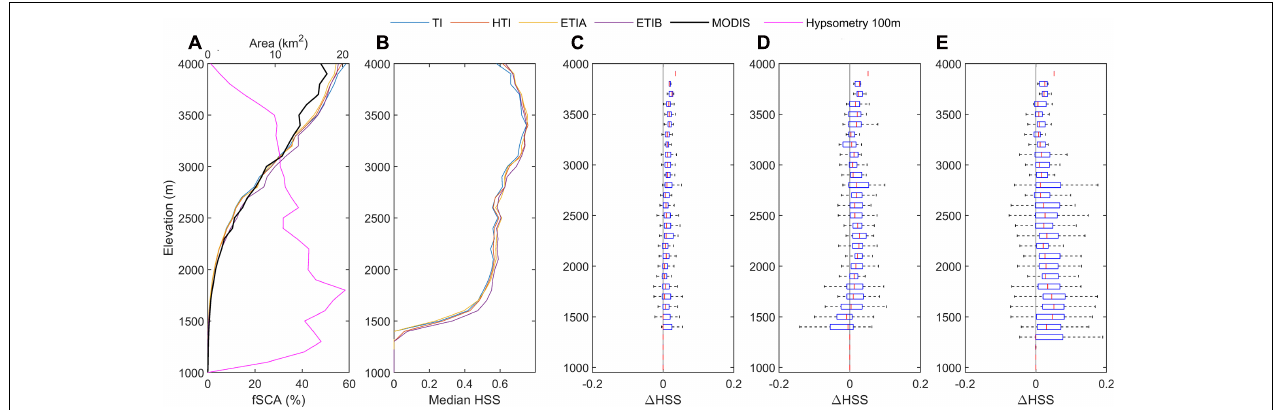
FIGURE 7 | Model validation and intercomparison by elevation. (A) Distribution of mean fSCA per elevation range and basin hypsometry. (B) Median HSS index of all models by elevation. (C–E) HSS differences between radiative and reference TI model by elevation range: (C) HTI. (D) ETIA. (E) ETIB.